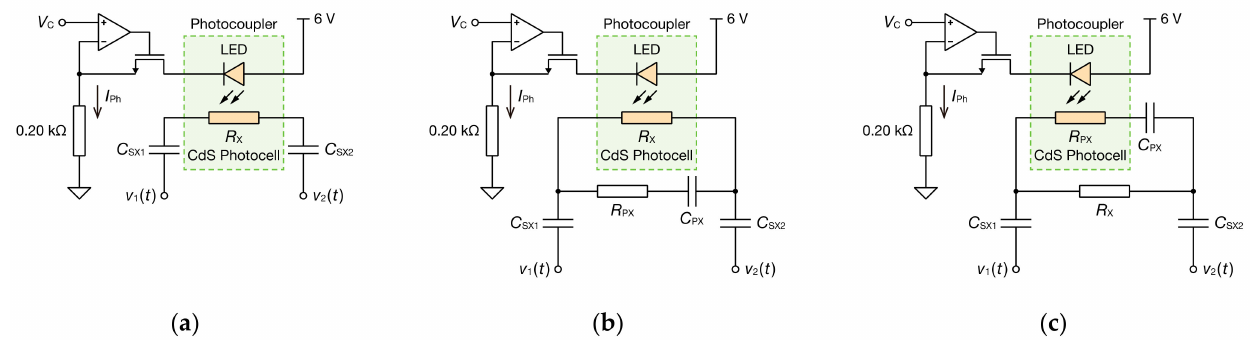
Figure 3. Constant current circuit for the LED current control of the photocoupler. The CdS photocell was used as ( a ) a single resistor, ( b ) a resistor R X of the bioimpedance model, or ( c ) R PX of its